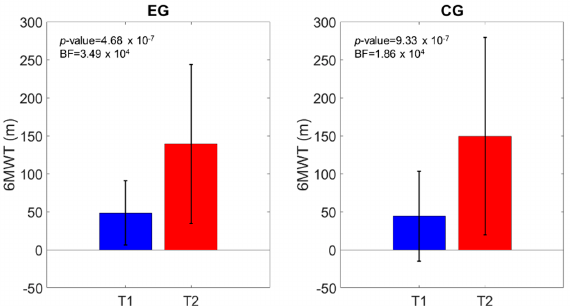
Figure 2. 6MWT distance comparison of the scores at T1 and T2. The p -value and the Bayes Factor (BF) of the intragroup effects are shown.